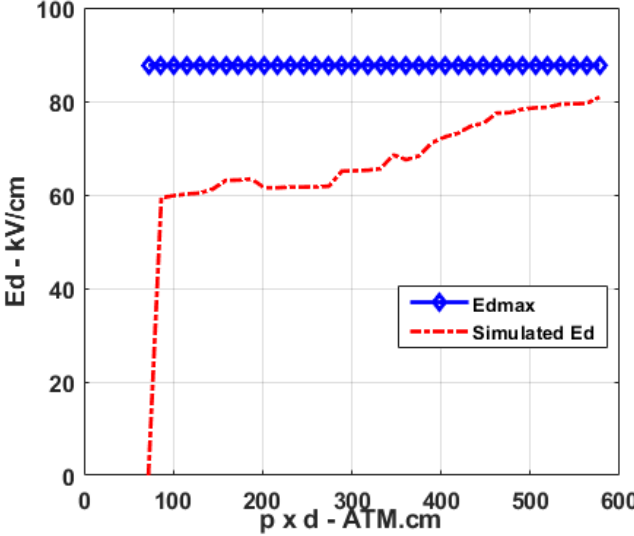
Figure 15. SF6 electric field strength during lightning impulse.